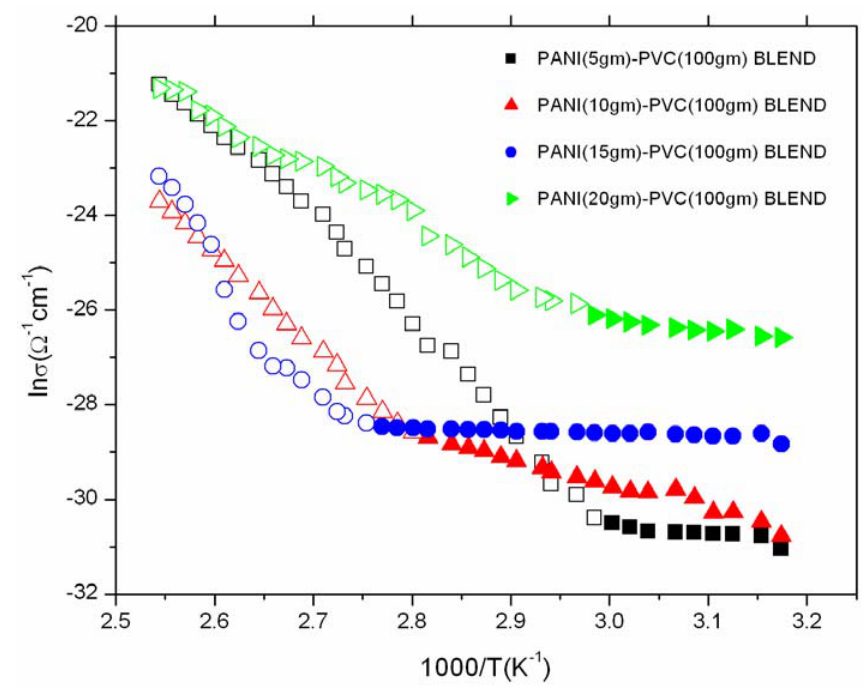
Fig. 3 Variation of dc conductivity with 1000/T for PANI doped with 5 % sulfamic acid in PANI-PVC